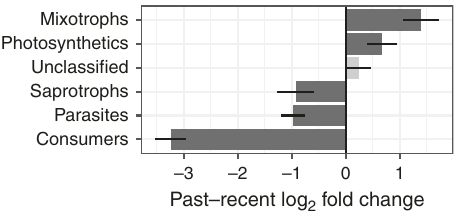
Fig. 4 Magnitude of change in trophic groups between the past and recent strata. Magnitude of change is expressed in log 2 fold change, as estimated by the DESeq2 analysis 75 ( n = 48 lakes). Dark bars represent groups for which the change was found signi fi cant (two-sided Wald test corrected with the Benjamini & Hochberg method p -value < 0.05). The change was found signi fi cant for mixotrophs ( p -value < 0.001), photosynthetics ( p -value = 0.022), saprotrophs ( p -value = 0.009), parasites ( p -value < 0.001), and consumers ( p -value < 0.001). The change was not found signi fi cant for the unclassi fi ed group ( p -value = 0.263). Horizontal lines show the standard